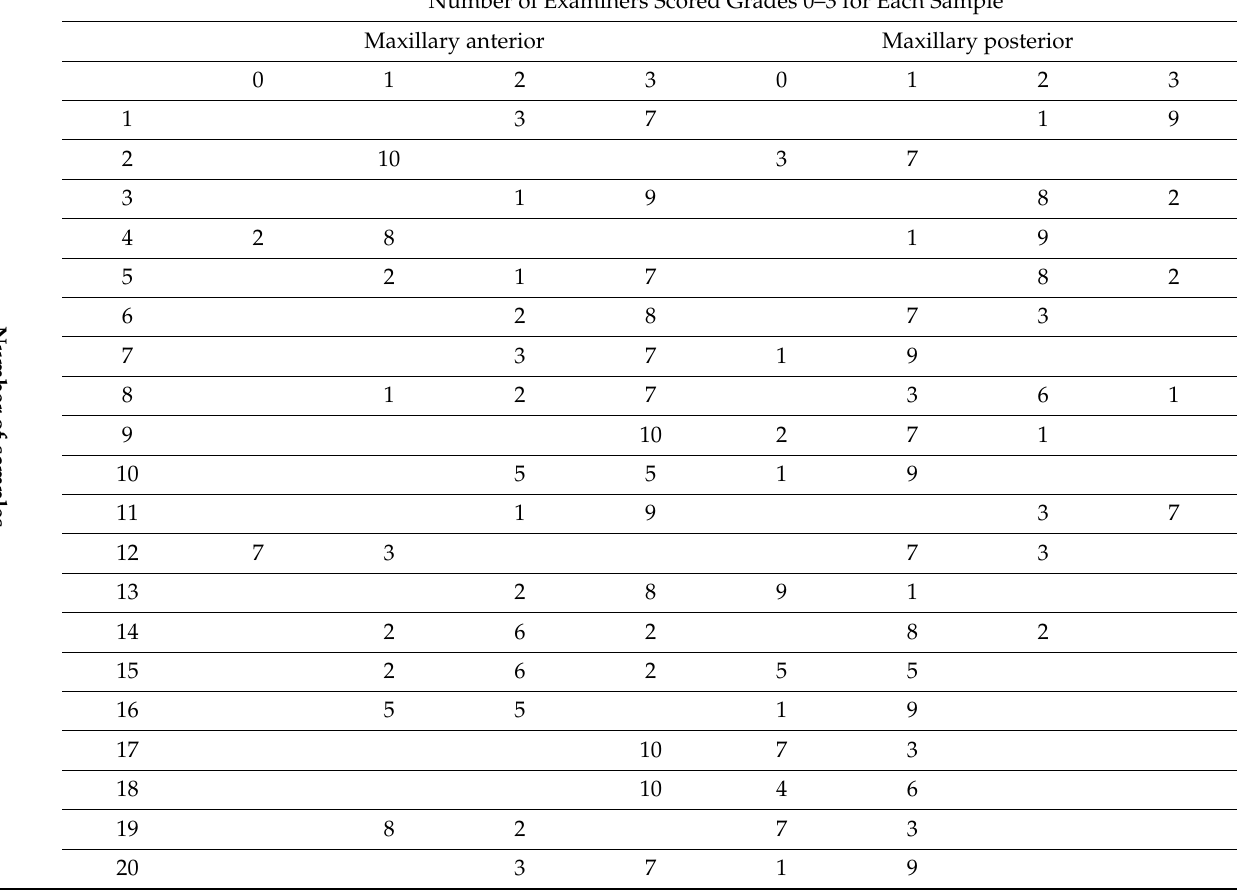
Table 3. Range of agreement between examiners in each case (upper